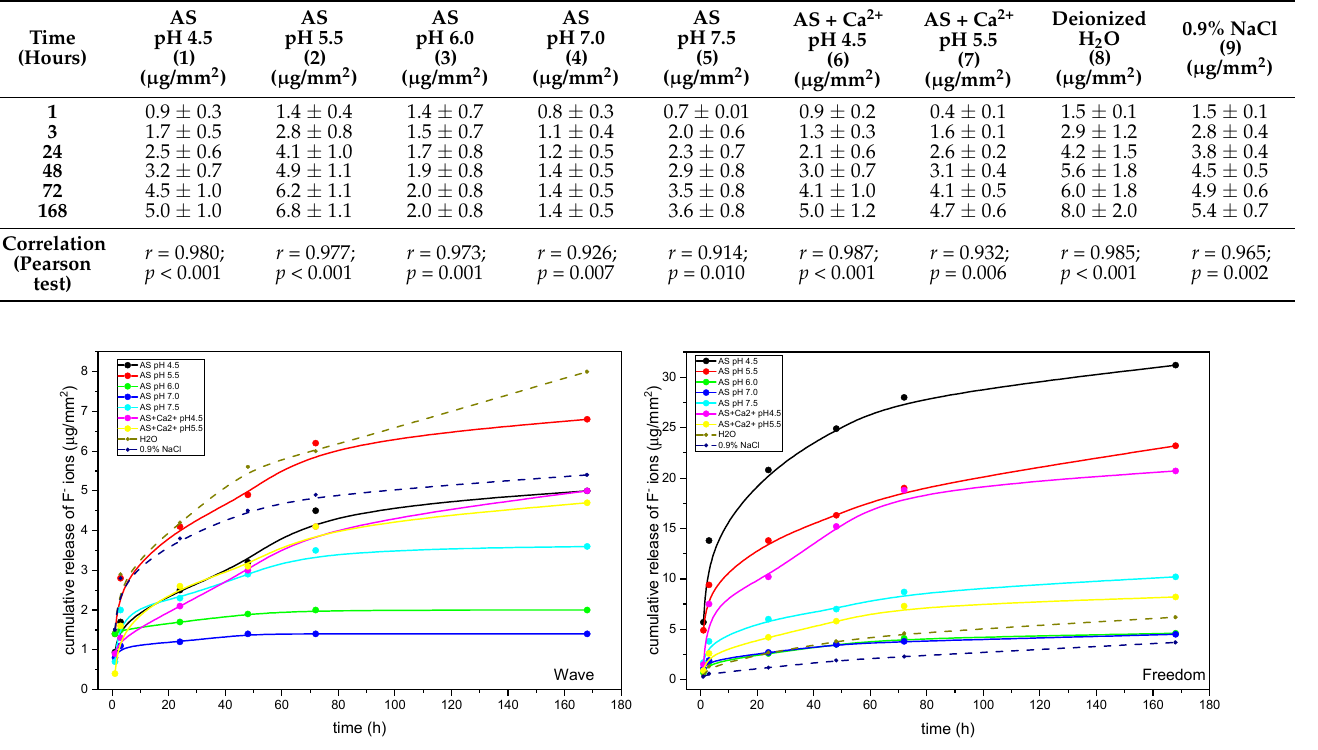
Figure 6. Cumulated release of fluoride ions ( µ g/mm2) from composite Wave ( left ) and compomer Freedom ( right ) into nine different solutions. Points represent means of measurements in time periods. AS: artificial saliva.